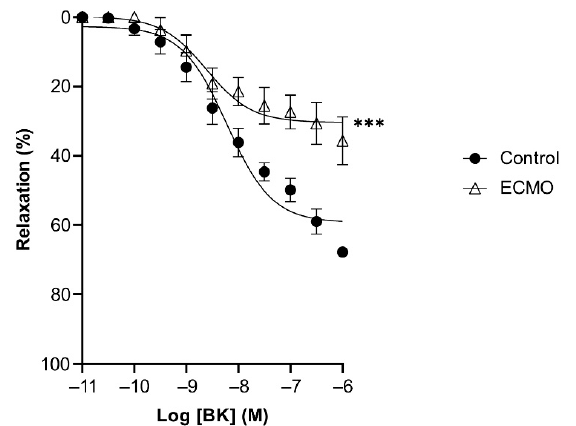
Figure 4. Relaxation in response to bradykinin (BK) is reduced in ECMO-treated coronary artery rings. Cumulative dose–response curves to BK in porcine coronary artery rings in control and ECMO group. Vessels were precontracted with U46619 (1 μ M). Data points are presented as mean ± S.E.M ( n = 5 in both groups). *** p < 0.0001 ECMO vs. Control. ECMO: extracorporeal membrane oxygenation. Table 2. Relaxant responses of porcine coronary arteries to relaxant agents.